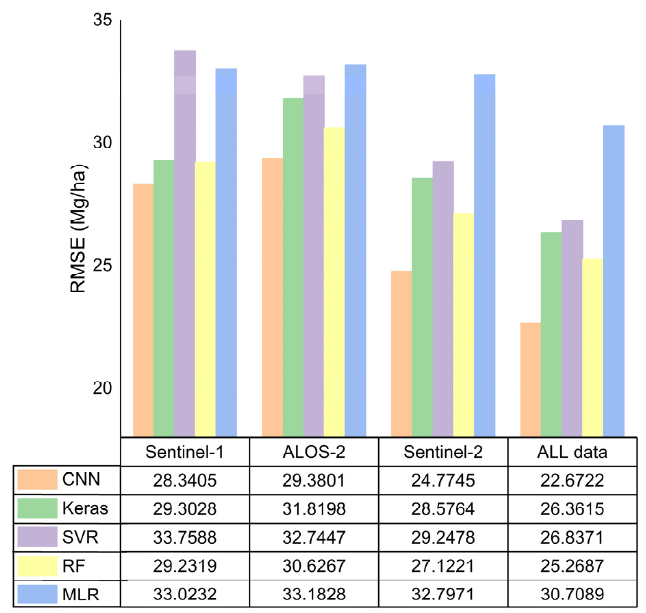
Figure 6. The RMSE comparison of five different algorithms by validation data.